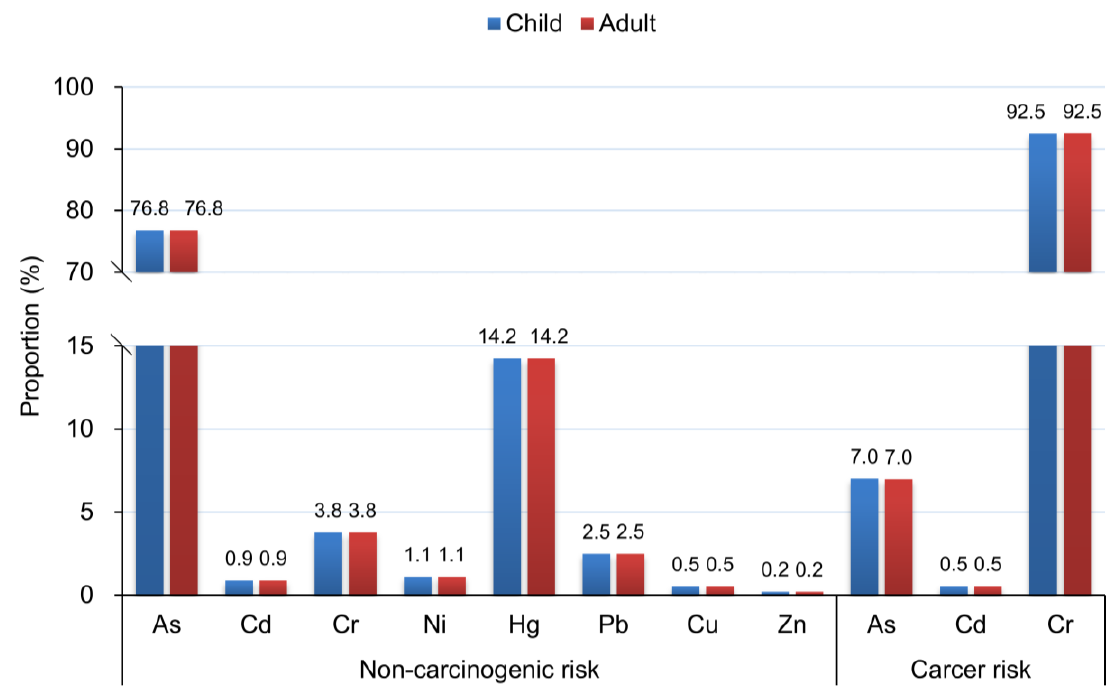
Figure 4. Proportion of non-carcinogenic and carcinogenic risks.